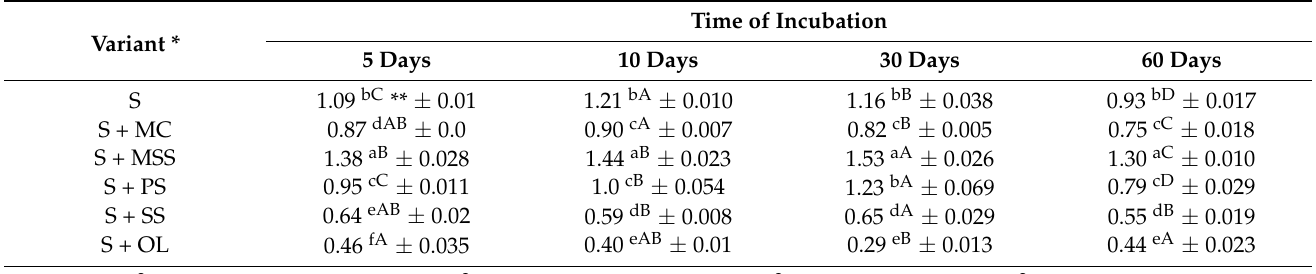
Table 4. The activity of dehydrogenase DEH (mg TPF kg − 1 24 h − 1